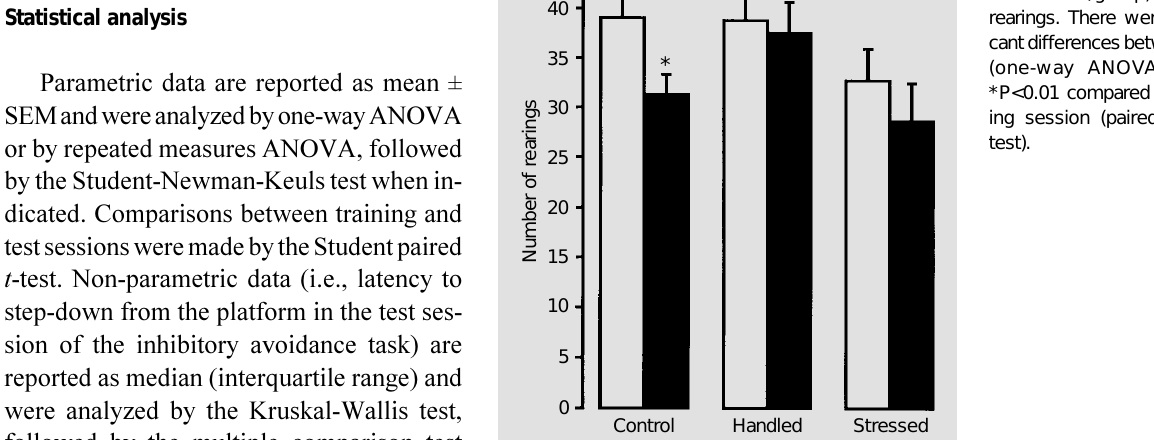
Figure 1 - Effect of chronic re- straint stress on performance in an open field task. Data are re- ported as mean ± SEM (N = 23- 24 animals/group) number of rearings. There were no signifi- cant differences between groups (one-way ANOVA, P>0.05). *P<0.01 compared to the train- ing session (paired Student t -